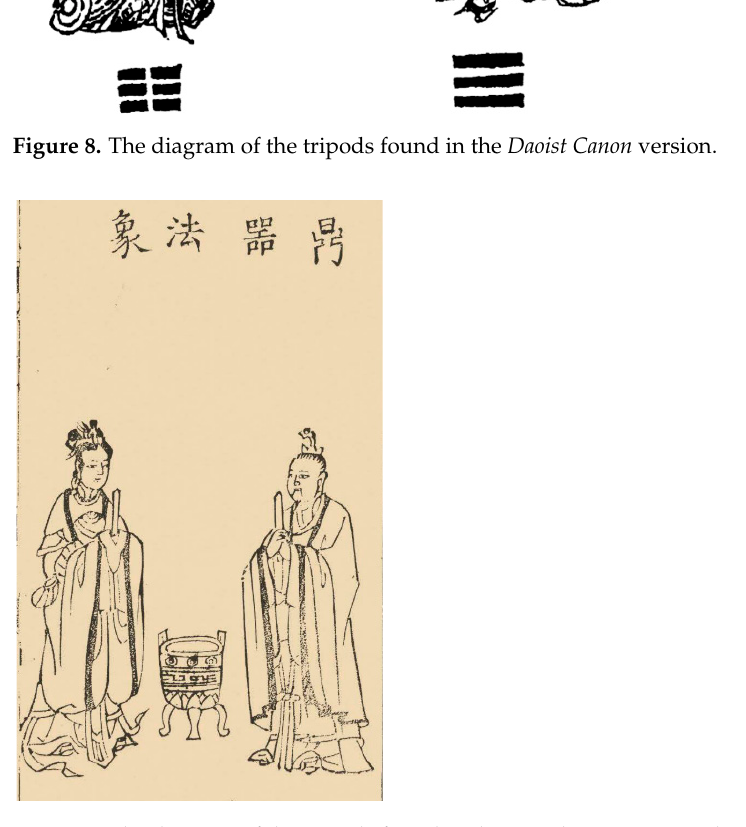
Figure 9. The diagram of the tripods found in the Hanchanzi annotated version.